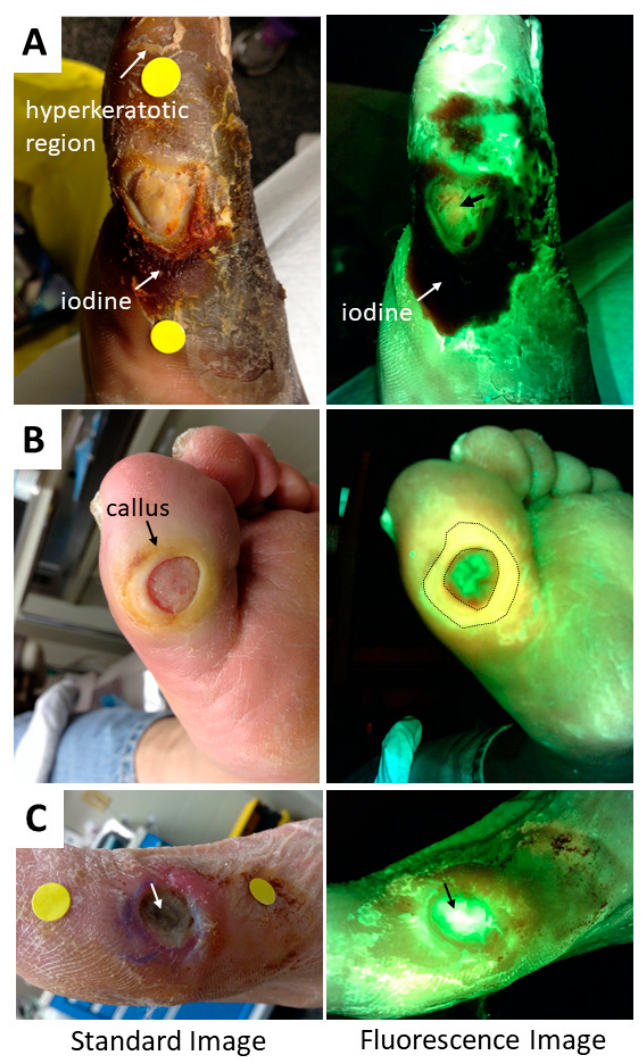
Figure 9. Challenging images to interpret. Standard and fluorescence images are shown for three diabetic foot ulcers (DFUs) which users may find challenging to interpret. ( A ) DFU with a region of hyperkeratosis (top of image), which fluoresces brightly (white) on fluorescence image. Iodine has been applied to the wound (reddish brown on standard image), resulting in large, dark regions on the fluorescence image. A faint blush red fluorescence was noted in the center of the wound bed, suggesting subsurface bacterial presence. A curettage sample was taken (black arrow denotes sampling location) and culture analysis found heavy growth of Serratia marcescens . ( B ) DFU with a heavy callus surrounding the wound. This callus tissue is expected to fluoresce bright green, however the callus region on the fluorescence image corresponded to a large region of yellow (circled). This led the clinician to suspect red bacterial fluorescence mixing with overlying green fluorescing tissue. This region was therefore sampled via curettage and cultures confirmed moderate growth of Staphylococcus aureus . ( C ) DFU with exposed bone (arrow) fluorescing bright white. This is shown to demonstrate how fluorescence from bone could be mistaken for P. aeruginosa if not compared to the standard image and assessed in conjunction with a standard clinical evaluation of the patient and their wound.